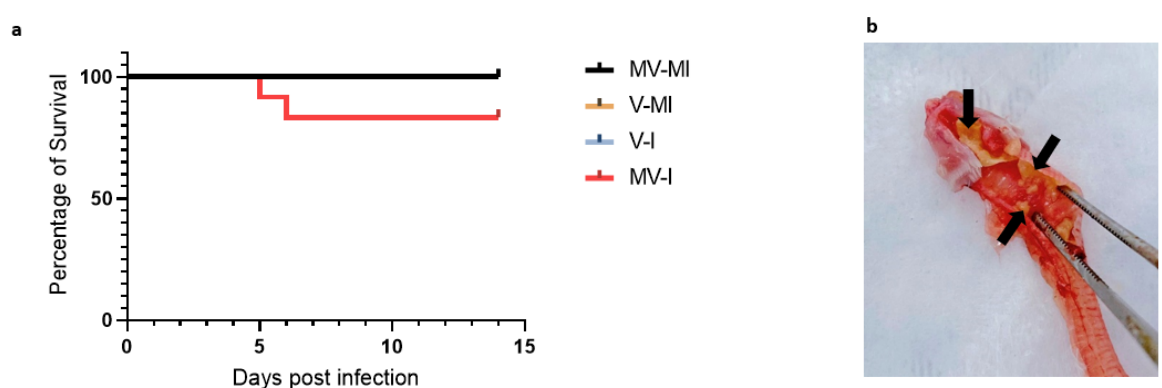
Figure 2. Percentage of survival ( a ) Percentages of remaining chicken following euthanasia of chickens reaching humane end point. Log rank (Mantel–Cox) test and Gehan–Breslow–Wilcoxon test were performed to identify group differences. ( b ) Post-mortem examination of trachea of a chicken euthanized at 6 dpi with fibrinous exudate in trachea (black arrows).